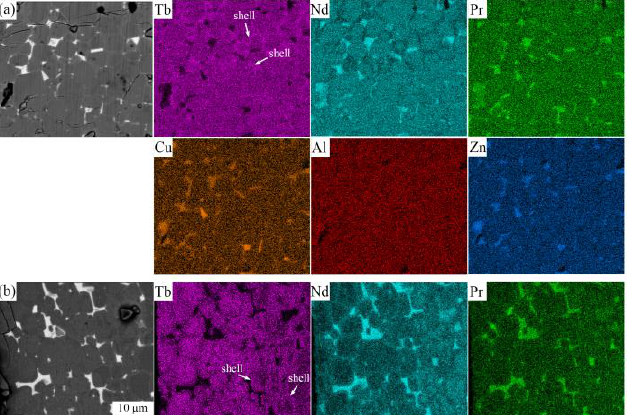
Figure 4. EDS mapping images on the surface of the GBD magnets at the depth of 0–50 μm: ( a ) Tb60 diffusion magnet and ( b ) Tb diffusion magnet.